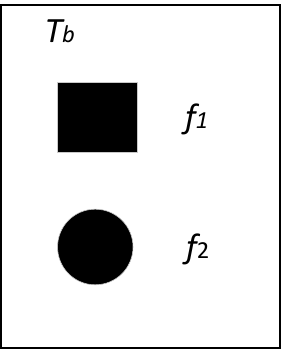
Figure 2. Test chart for calculating MDTD.